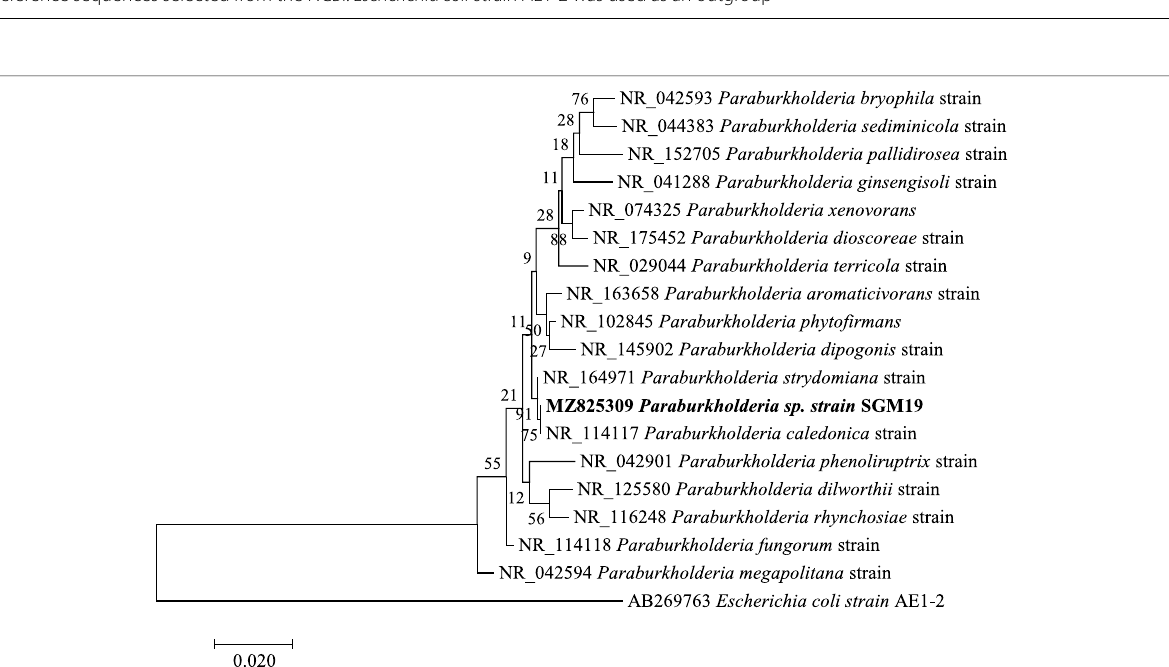
Fig. 6 Maximum likelihood phylogenetic tree based on analysis of partial 16S rRNA nucleotide sequence of Pantoea sp. strain SGM18 with reference sequences selected from the NCBI. Escherichia coli strain AE1-2 was used as an outgroup